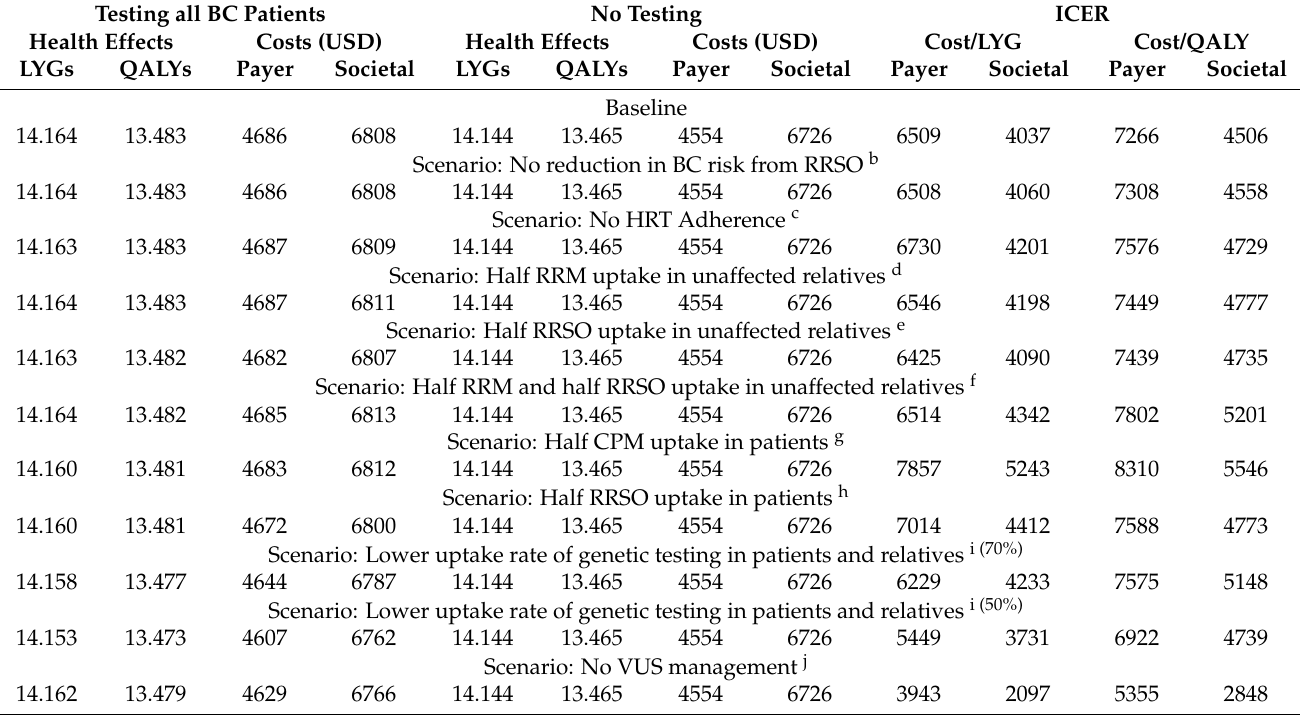
Table 2. Lifetime discounted costs and effects per woman and ICER after genetic testing for all patients with BC a .